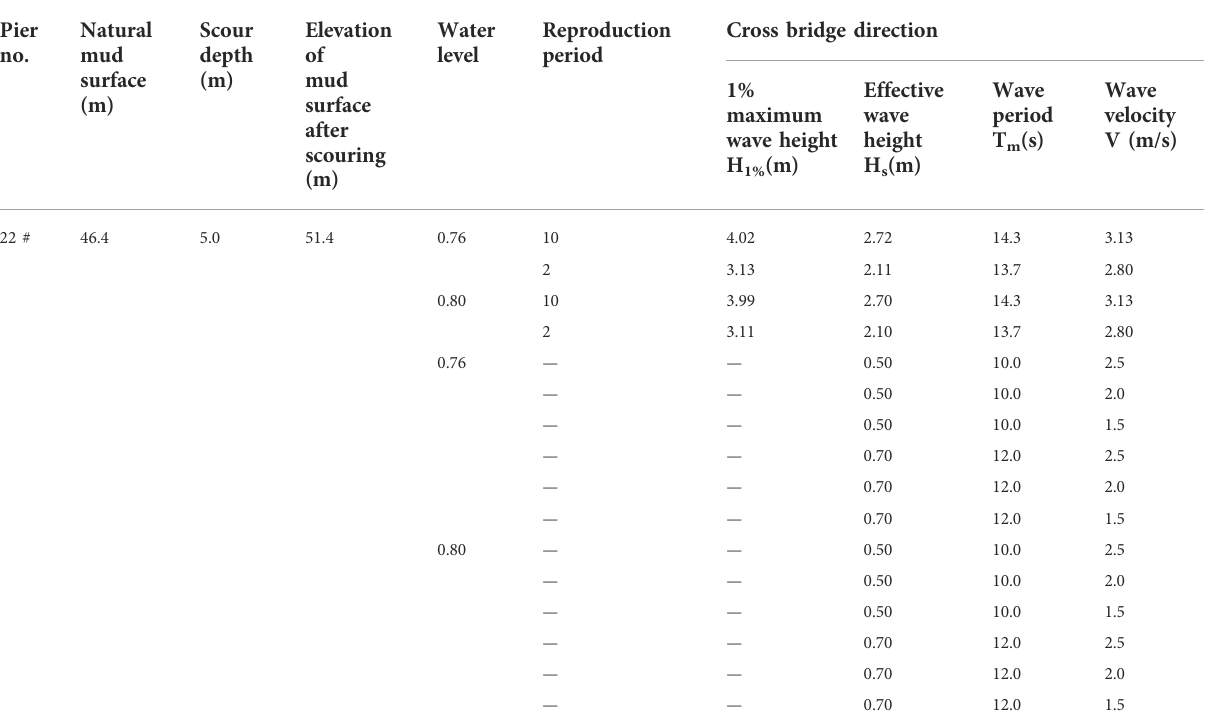
TABLE 1 Wave and current characteristics (Construction platform + steel casing). Pier